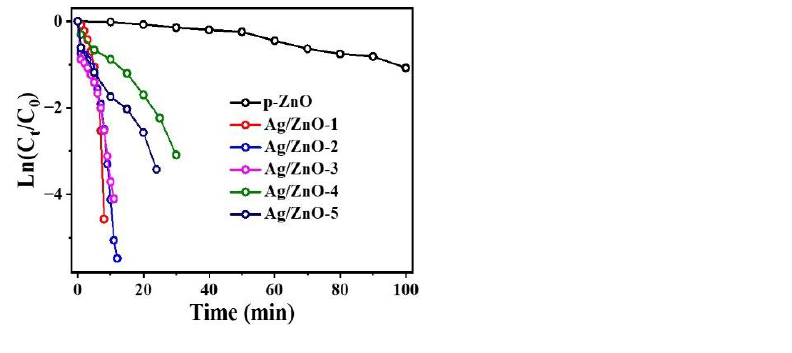
Figure 5. Plots of Ln(C t /C 0 ) versus the reaction time for the reduction of 4-NP over the Ag/p-ZnO heterostructure under natural light.